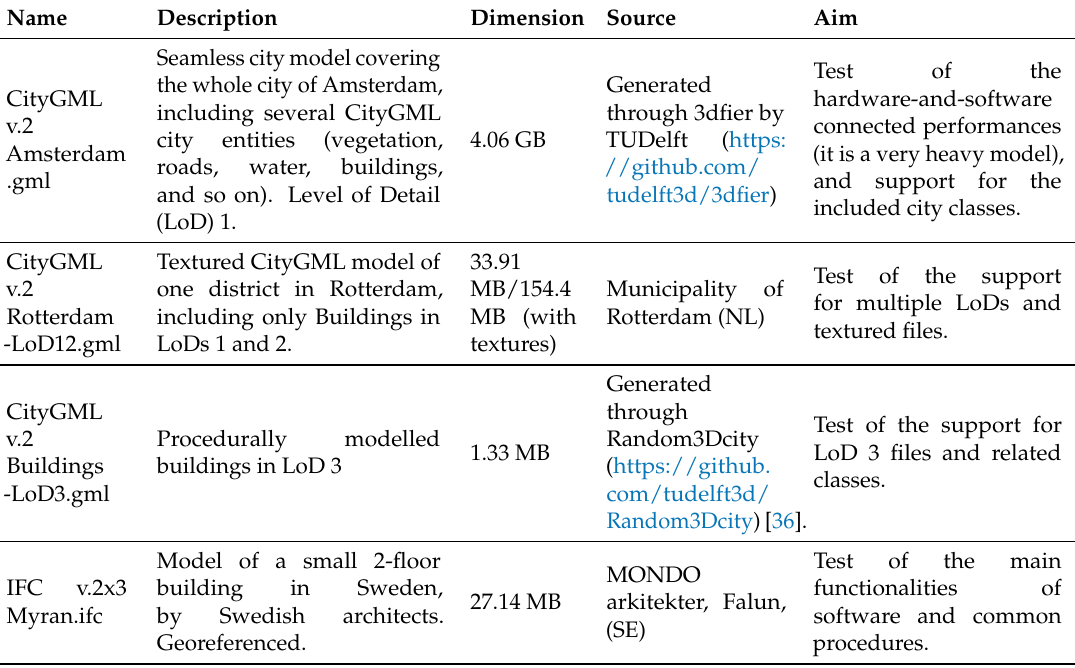
Table 3. Provided CityGML and IFC data for the GeoBIM benchmark